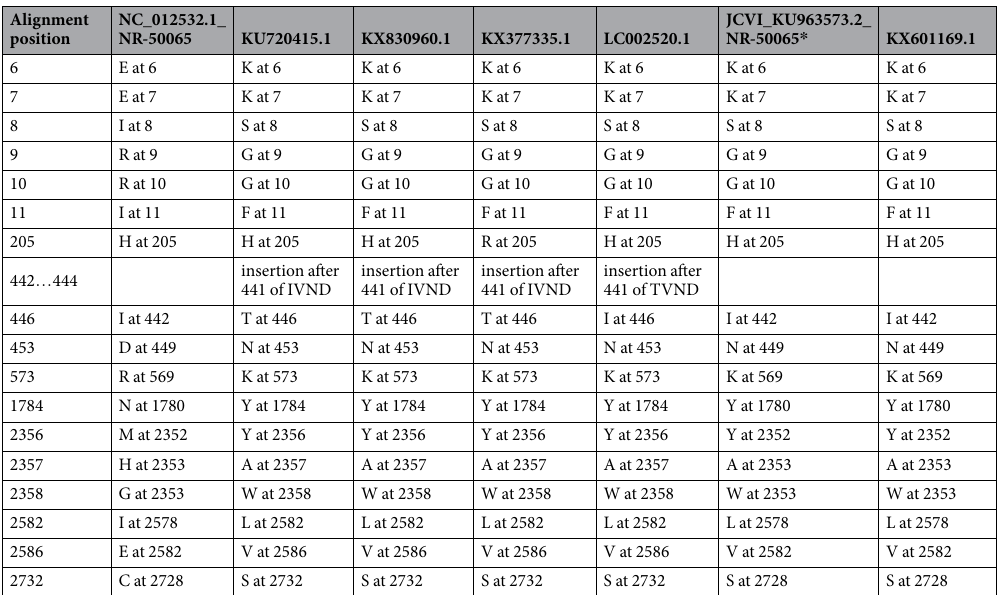
Table 2. Substitutions in the polyprotein of different UGA/MR-766/1947 sequences, with numbers representing the amino acid positions in the polyprotein for each sequence. * Sequenced at JCVI as part of the current work.